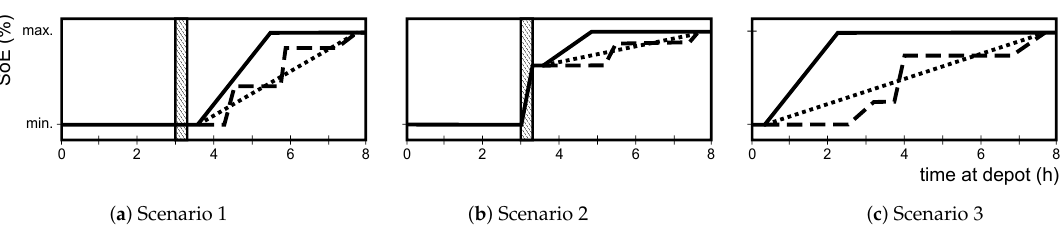
Figure 6. Charging process considering the introduced charging